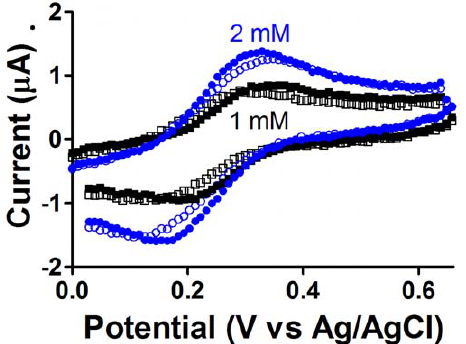
Figure 3. The CheapStat is compatible with common educa- tional experiments. Shown is the cyclic voltammetry-based moni- toring of potassium ferricyanide in 1 M potassium nitrate solution, using both commercial (filled symbols) and hand fabricated (open symbols) Ag/AgCl reference electrodes. Ferricyanide concentrations of 1 mM (black squares) and 2 mM (blue circles) were interrogated via cyclic voltammetry and show the characteristic voltammetric response of a fully reversible